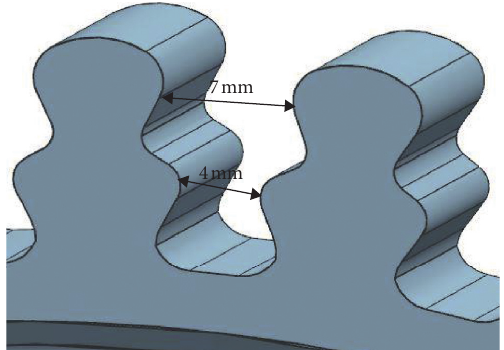
Figure 1: Structural diagram of the mortise of turbine disk.